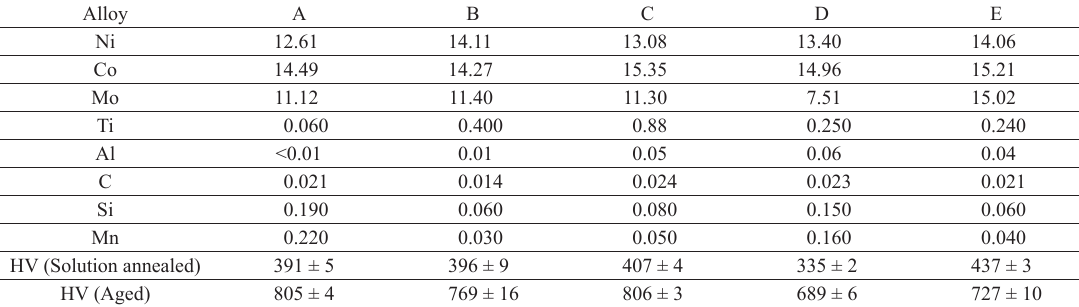
Table 3. Chemical composition (wt.%) of five experimental alloys and the Vickers hardness (HV 0.3) after solution annealing (850 °C – 1 h/air) and aging (480 °C – 5 h/H 2